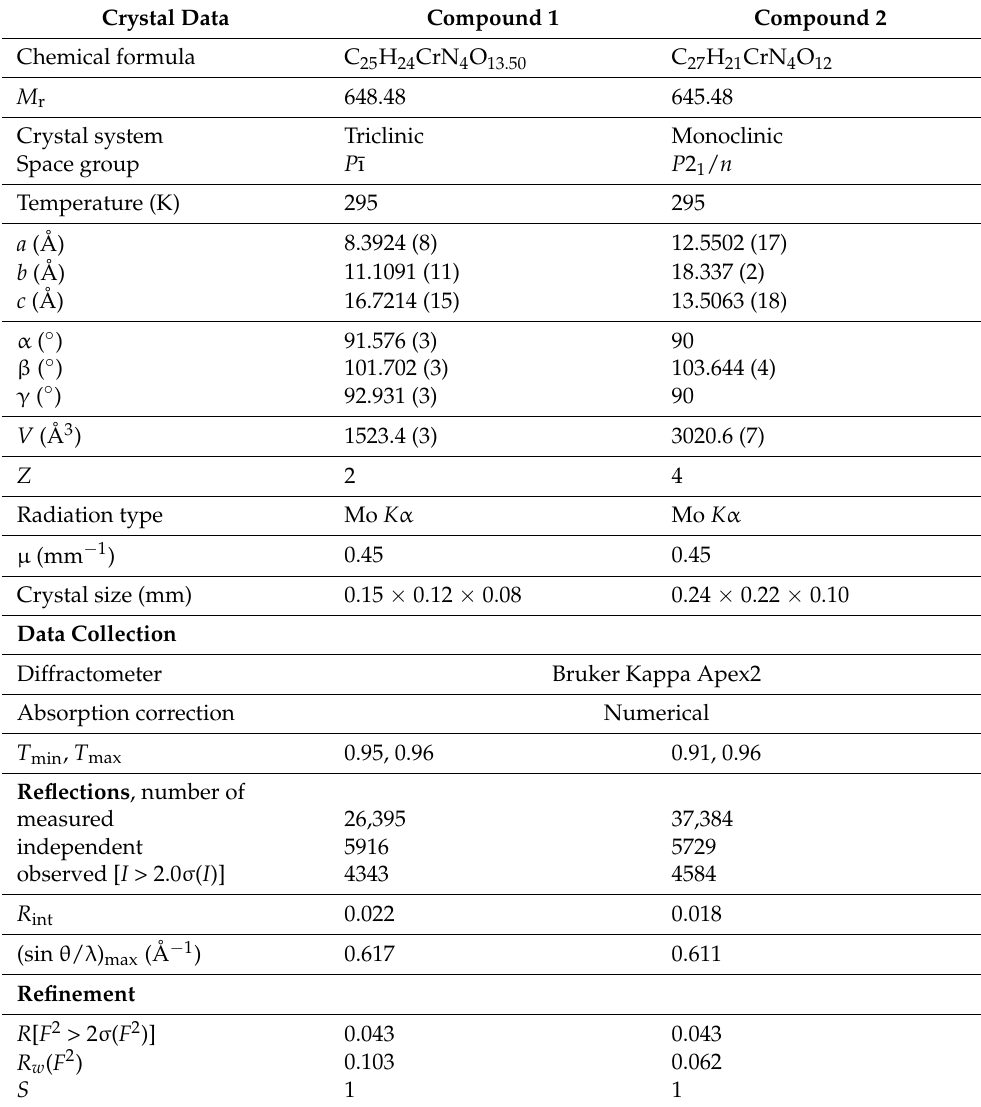
Table 2. Experimental X-ray crystallographic details on the compounds [Cr(C 15 H 9 O 4 )(C 10 H 8 N 2